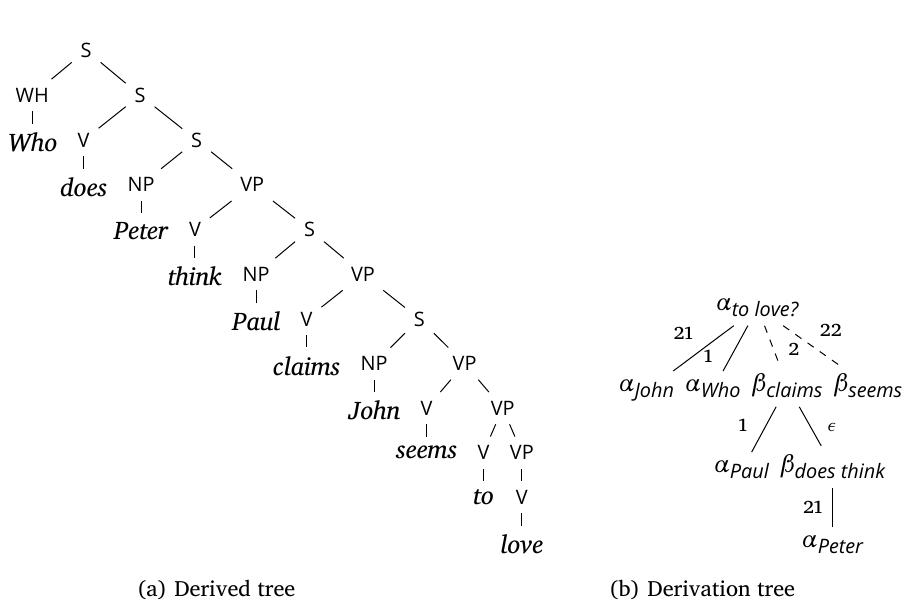
Figure 19: TAG analysis of Who does Peter think Paul claims John seems to love Figure 17(b), 18(b), and 19(b) respectively. We leave it to the reader to check that the G derived trees interpretations of theses terms are the derived trees of the corresponding figures 17(a), 18(a), and 19(a)